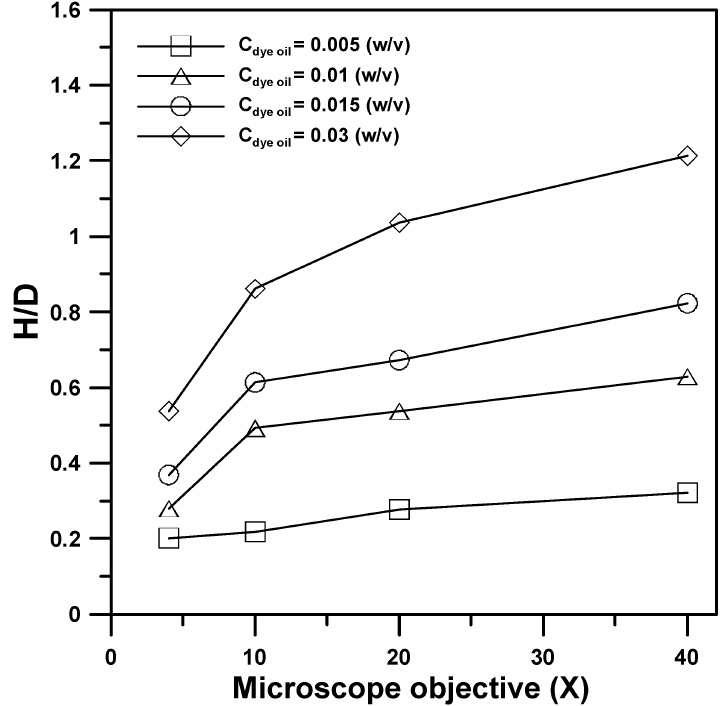
Figure 5. The nondimensional height ( H / D ) of the produced microlens structures with respect to the objective magnifications from 4× to 40× for the EFM-3D mask filled with dye oils at C dye oil = 0.005 to 0.03 ( w / v)